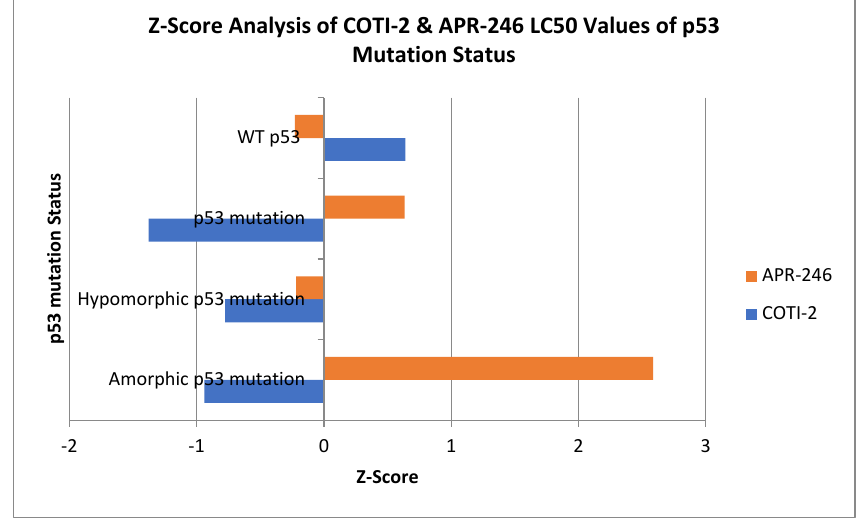
Figure 3. Z-Score Analysis of COTI-2 & APR-246 LC50 Values of p53 Mutation Status. Z-Score analysis by P53 mutational status compares APR and COTI activity against wild-type versus mutated and amorphic (low or no functional protein) versus hypomorphic (altered protein structure) P53 subtypes. Results falling to the left of mean are more sensitive. Results falling to the right of mean are more resistant.